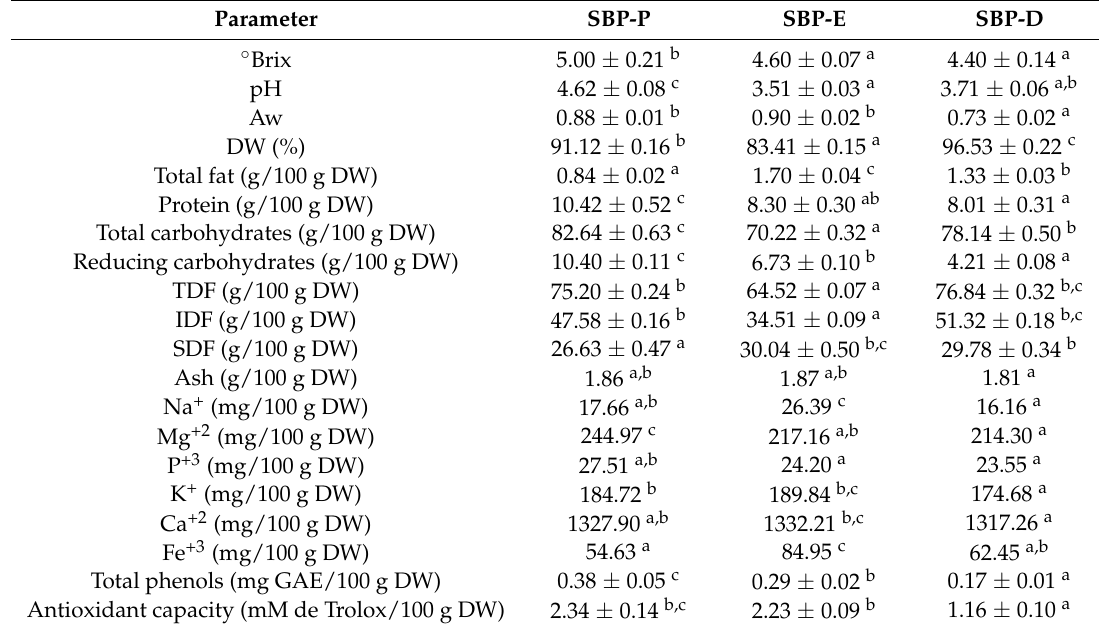
Table 1. Chemical composition of sugar beet pulp by-products (g/100 g